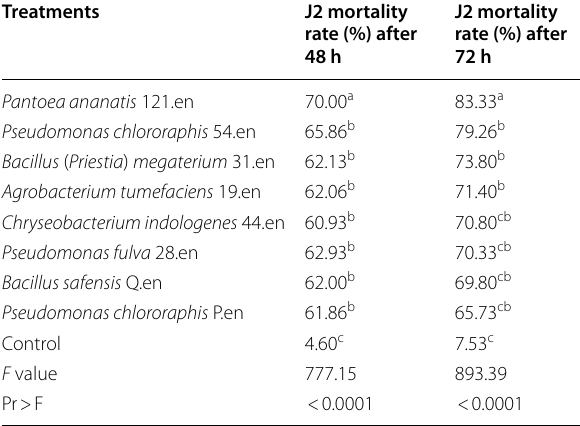
Table 2 Mean comparison of percentage of mortality of J2s in some bacterial